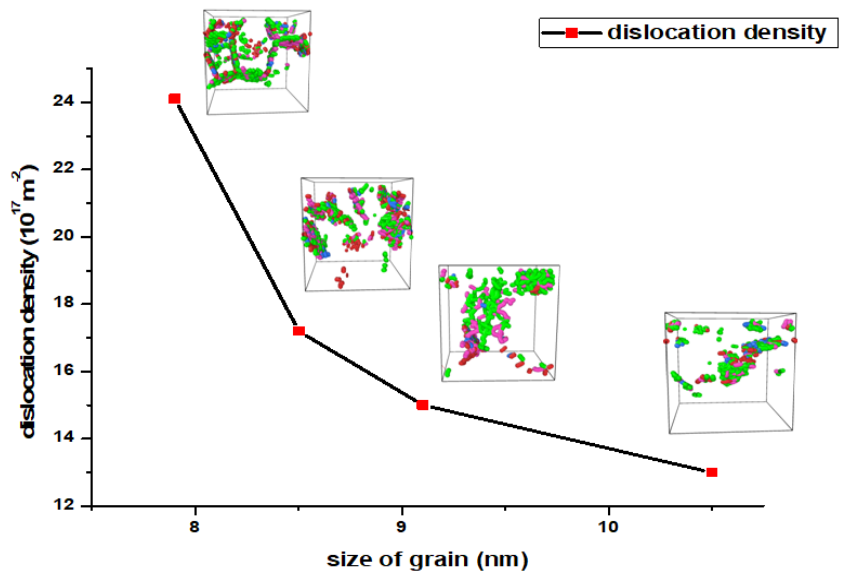
Figure 4. Dislocation density vs. grain size with the dislocation analysis results of a nanodentation simulation showing the extracted dislocation line network for varied grain sizes.